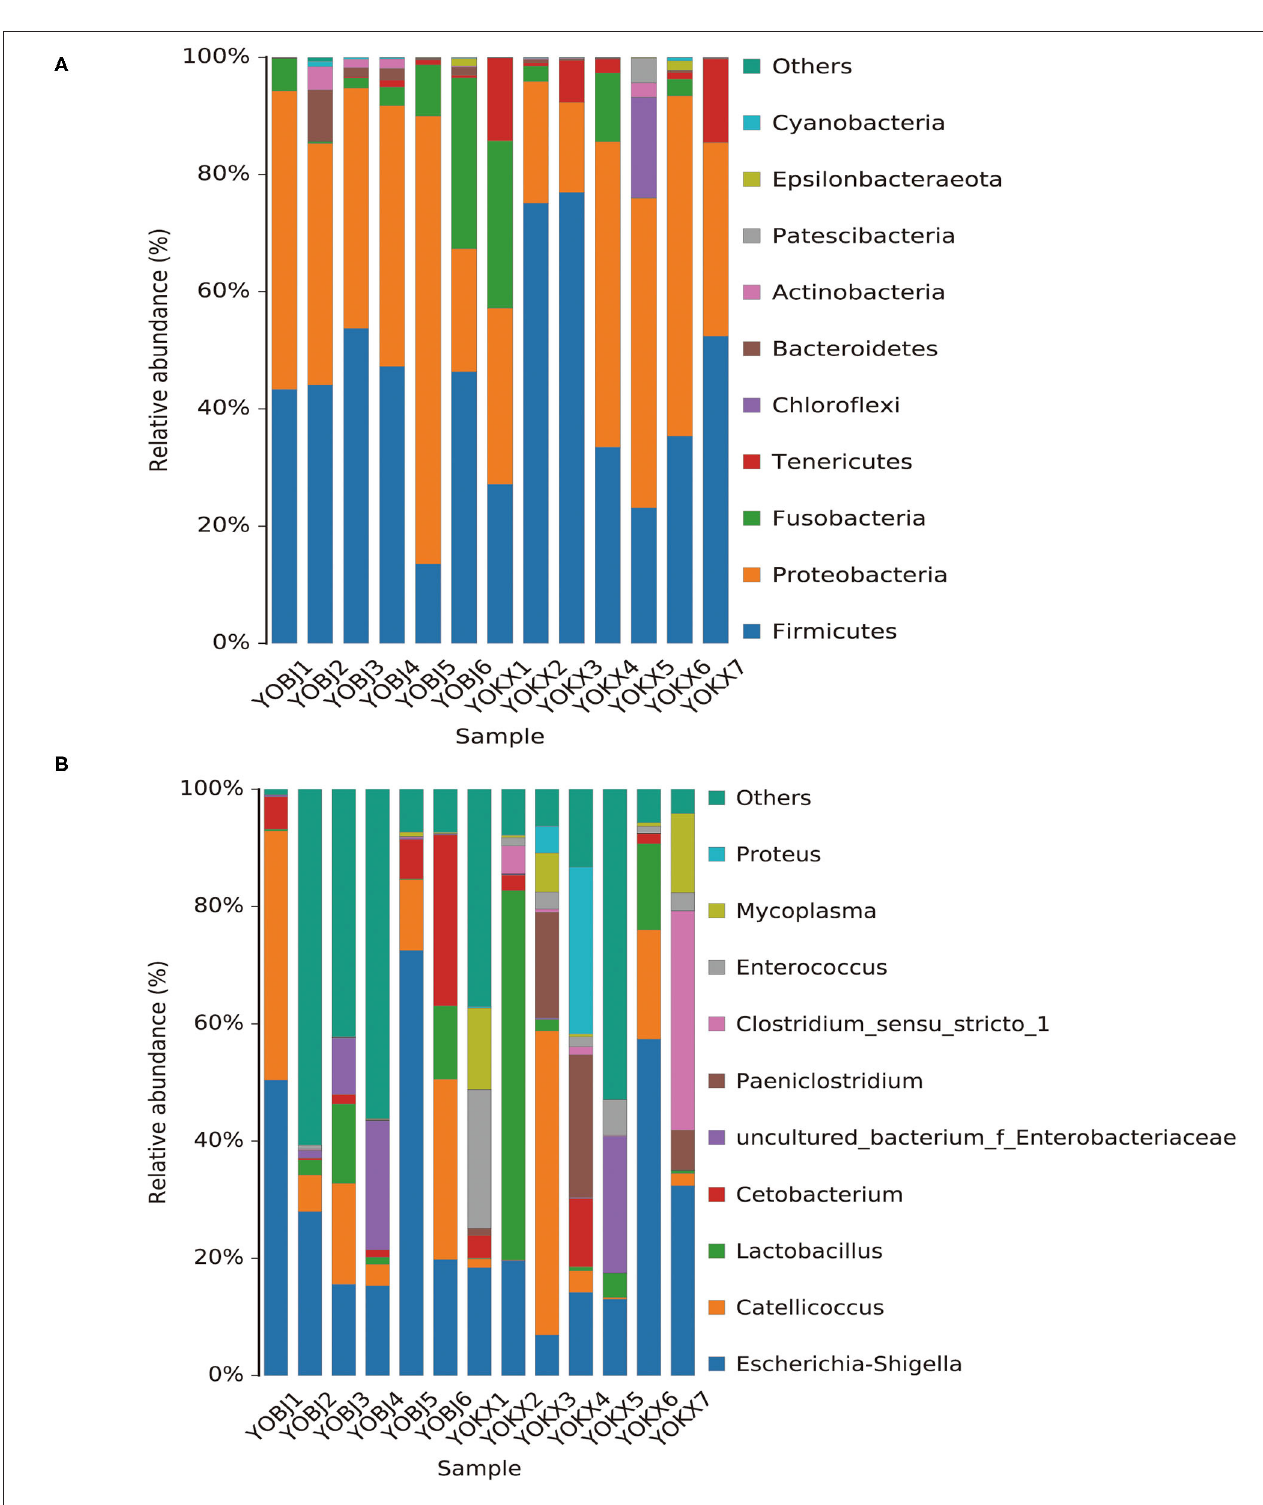
FIGURE 5 | Bar graph of the relative bacterial abundance at phylum (A) and genus (B) levels. The Bacterial those with relative abundance (%) over 1% were shown. Others are bacterial with a relative abundance of < 1%. BJ, Bojiang Haizi; KX, Mu Us Desert.